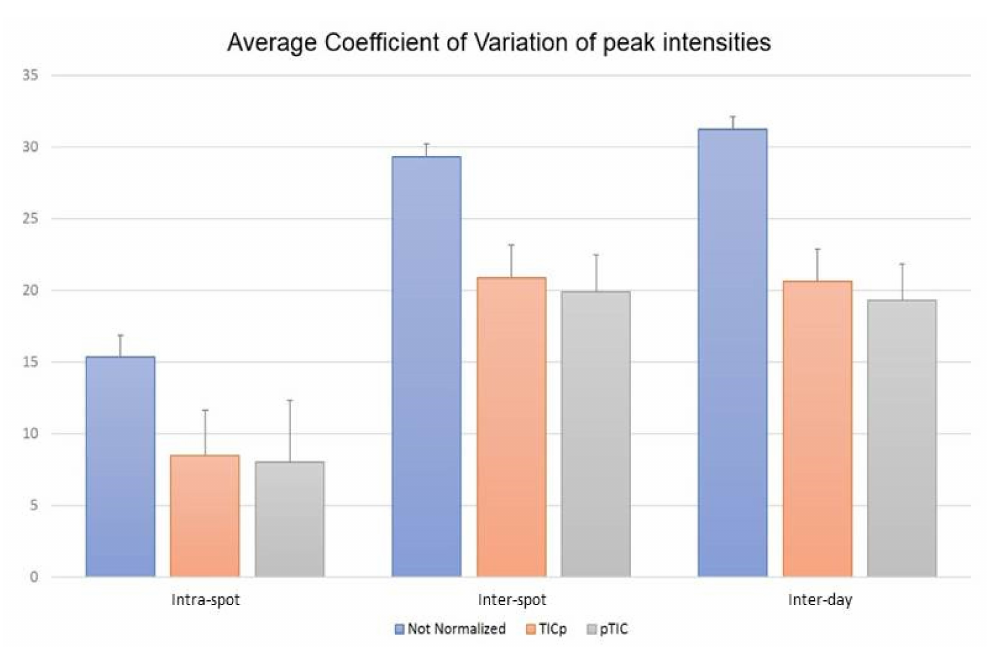
Figure 3. Coefficient of variation (CV) means for the intensity of the 18 common protein peaks of E. faecium analyzed at the intra-spot, inter-spot and inter-day levels using raw data (non-normalized) and both normalizations methods—before (TICp) and after (pTIC) finding